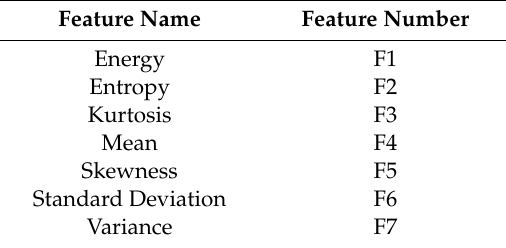
Table 2. Histogram feature sets.